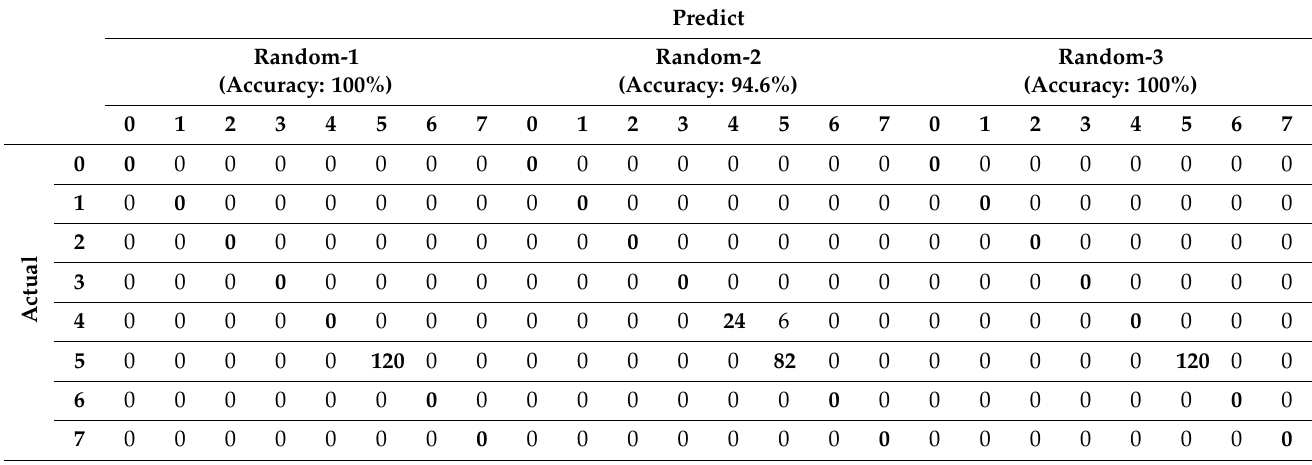
Table 7. Confusion matrix for Room 1 Sequence 7 (with median filter).